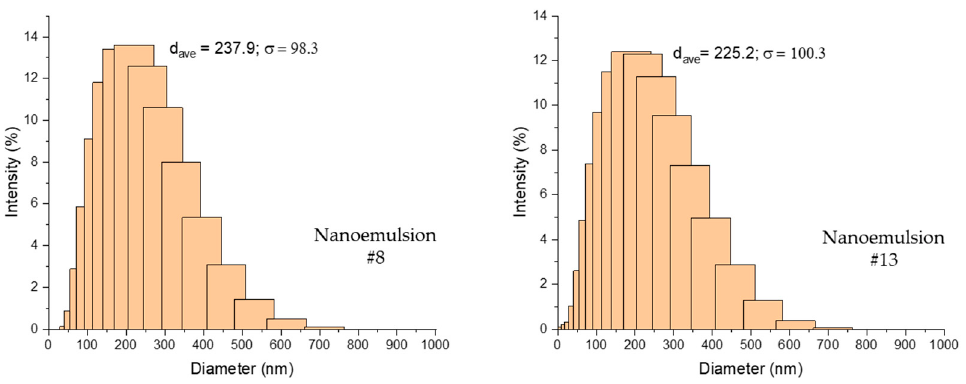
Figure 1. Z-averaged droplet size distribution of the least (# 8) and the most stable (#13) w/o/w nanoemulsions.